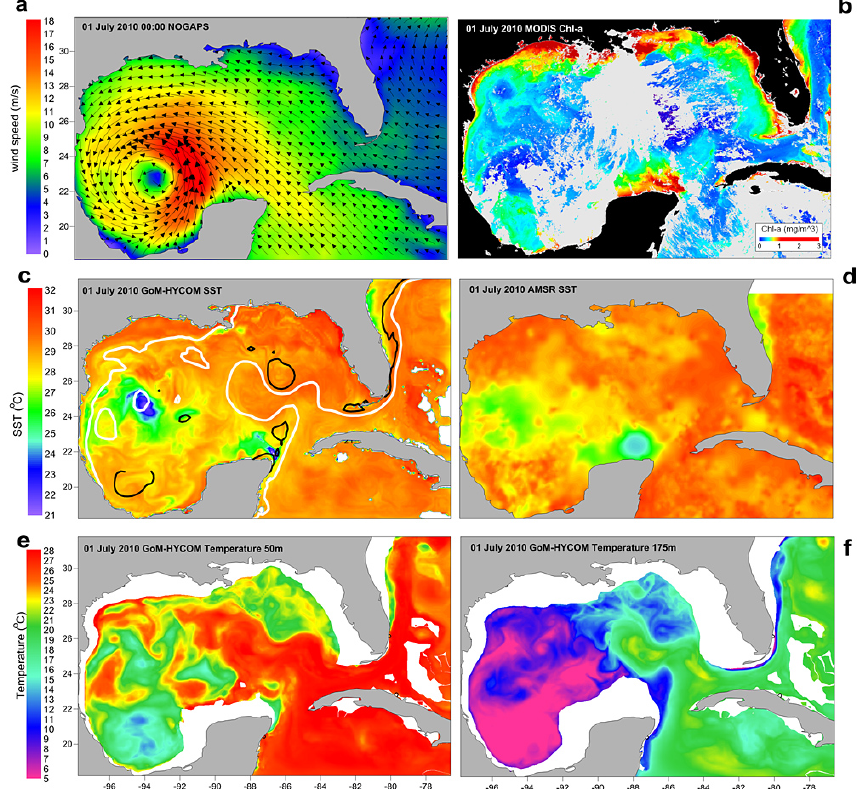
Figure 9. Horizontal distribution over the GoM-HYCOM region on 1 July 2010 of (a) wind stress (vectors, m 2 s − 1 ) and wind speed magnitude (colors, ms − 1 ) from the NOGAPS model, (b) satellite MODIS chl a (mgm − 3 ) , (c) model Sea Surface Temperature (SST, ◦ C) with superimposed model Sea Surface Height (SSH) contours (white lines: 17cm; black lines: − 8cm), (d) satellite AMSR SST ( ◦ C), (e) model temperature ( ◦ C) at 50m, and (f) model temperature ( ◦ C) at